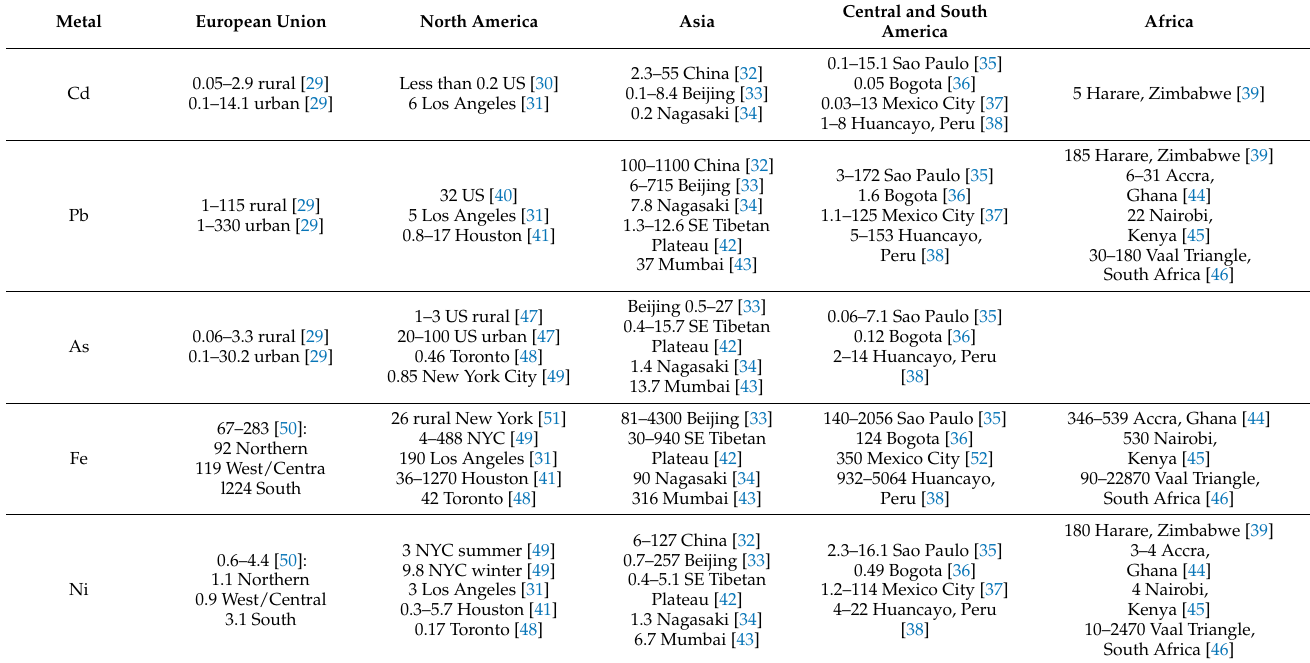
Table 2. Metal concentration mean or range of means in ambient PM 2.5 , as reported in various regions of the world (ng/m 3 ). Metal European